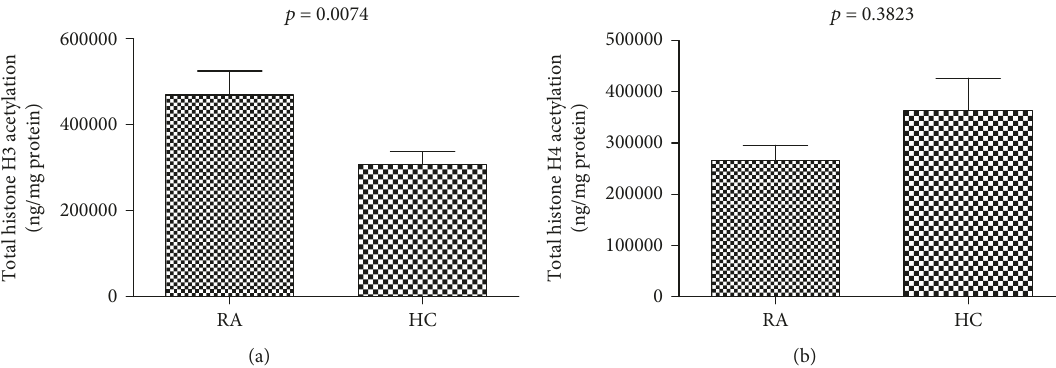
Figure 5: The level of total histone H3 and H4 acetylation in PBMCs of RA patients compared to HCs. The total histone H3 and H4 acetylation levels were measured using the colorimetric histone H3 and H4 acetylation assay. (a) A signi fi cant increase in total histone H3 acetylation levels in RA ( n = 12 ) PBMCs compared to HCs ( n = 10 ). (b) Lower but not statistical signi fi cance in the total histone H4 acetylation levels between RA patients and HCs.